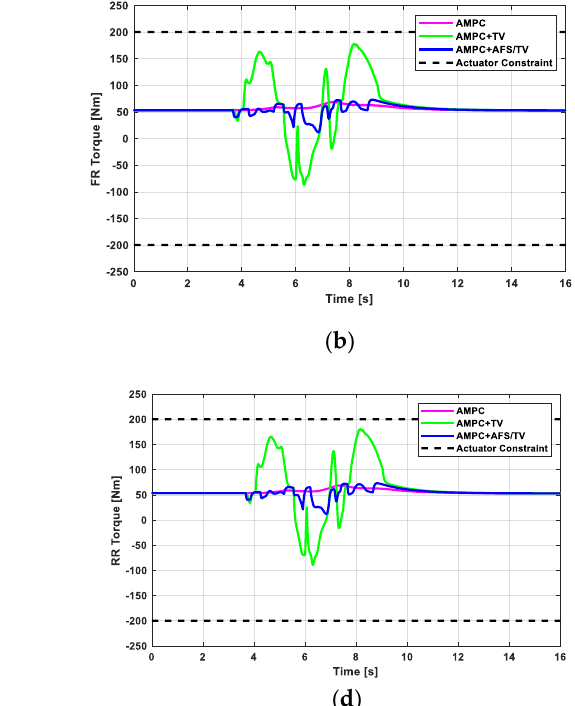
Figure 8. ( a ) Front steer angle and ( b ) desired yaw moment by torque vectoring (TV).